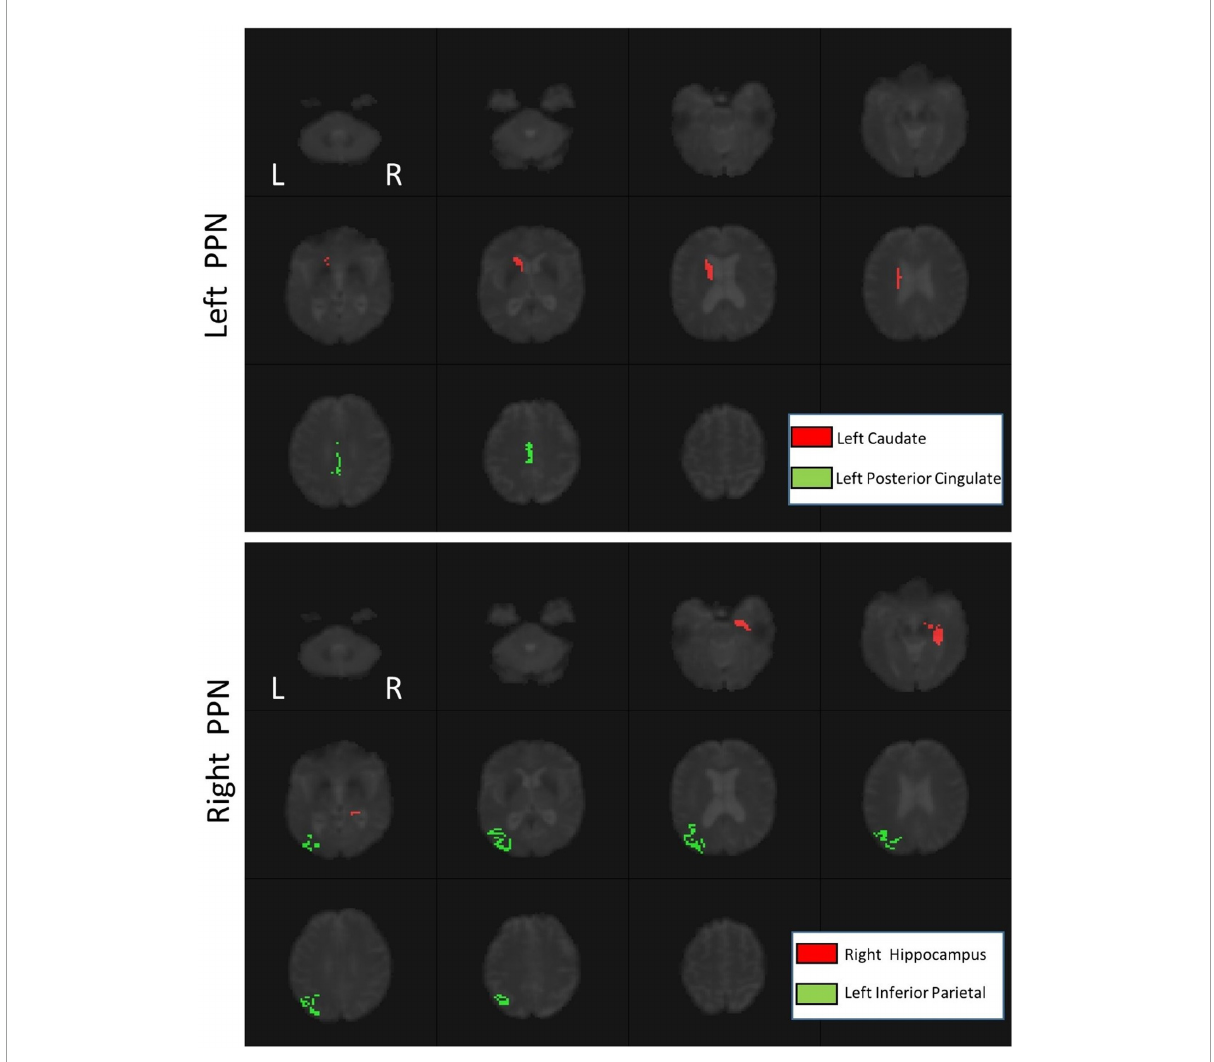
FIGURE3 The functional connectivity of the left PPN (top) and right PPN